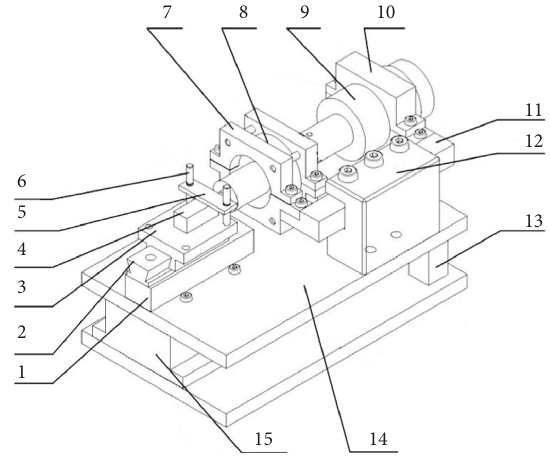
Figure 6: 3D assembly effect drawing of UVARM system.